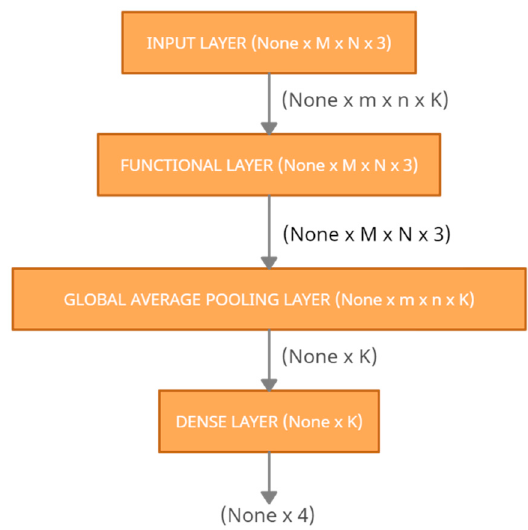
Figure 17. Basic structure for our three models.